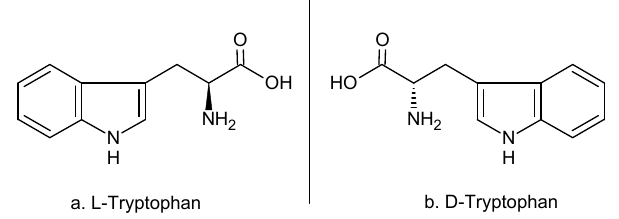
Figure 2. The chemical structure of the two enantiomers. (adapted from [5]).